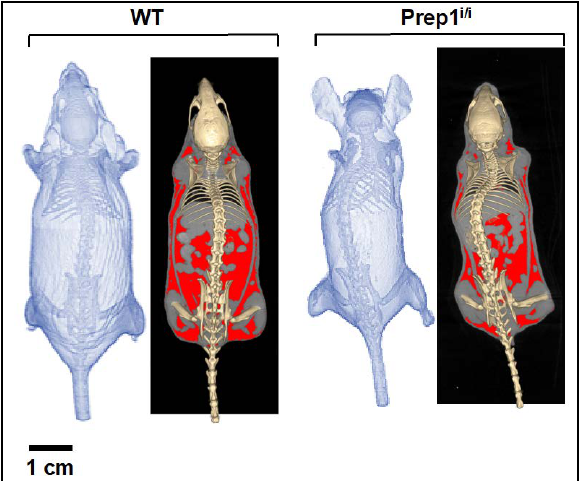
Figure 2. Volumetric rendering of the whole body micro-CT reconstructions indicates on average a smaller, lighter, shorter and less adipose tissue in hypomorphic mice. A wt mouse (left) and a Prep1 i/i mouse (right) are represented. In the right panel of each group, the highlighted region represents the segmented adipose tissue. Table 1. Summary of the in vivo morphometric analysis. Comparison between the two groups for each variable are performed by Mann-Whitney non-parametric test. An asterisk (*) after the p -value denotes a significant difference between groups.